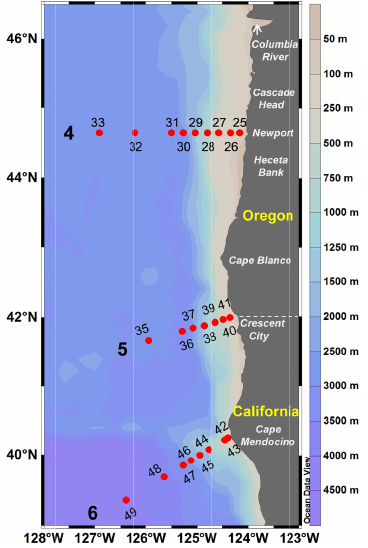
Figure 1. Map of offshore Oregon and northern California (US west coast) showing the topography and the locations of sampling sta- tions along transects 4, 5 and 6 in spring/early summer